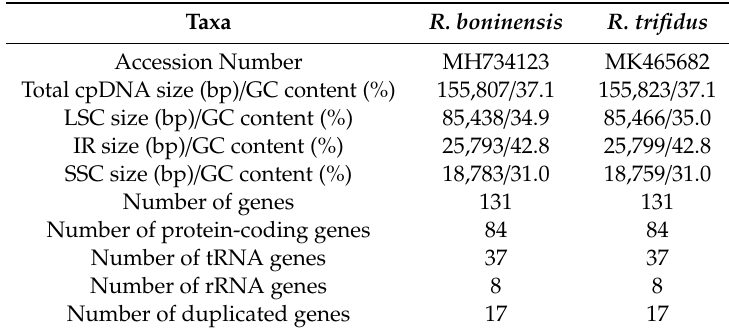
Table 1. Summary of the characteristics of R. boninensis and R. trifidus chloroplast genomes.